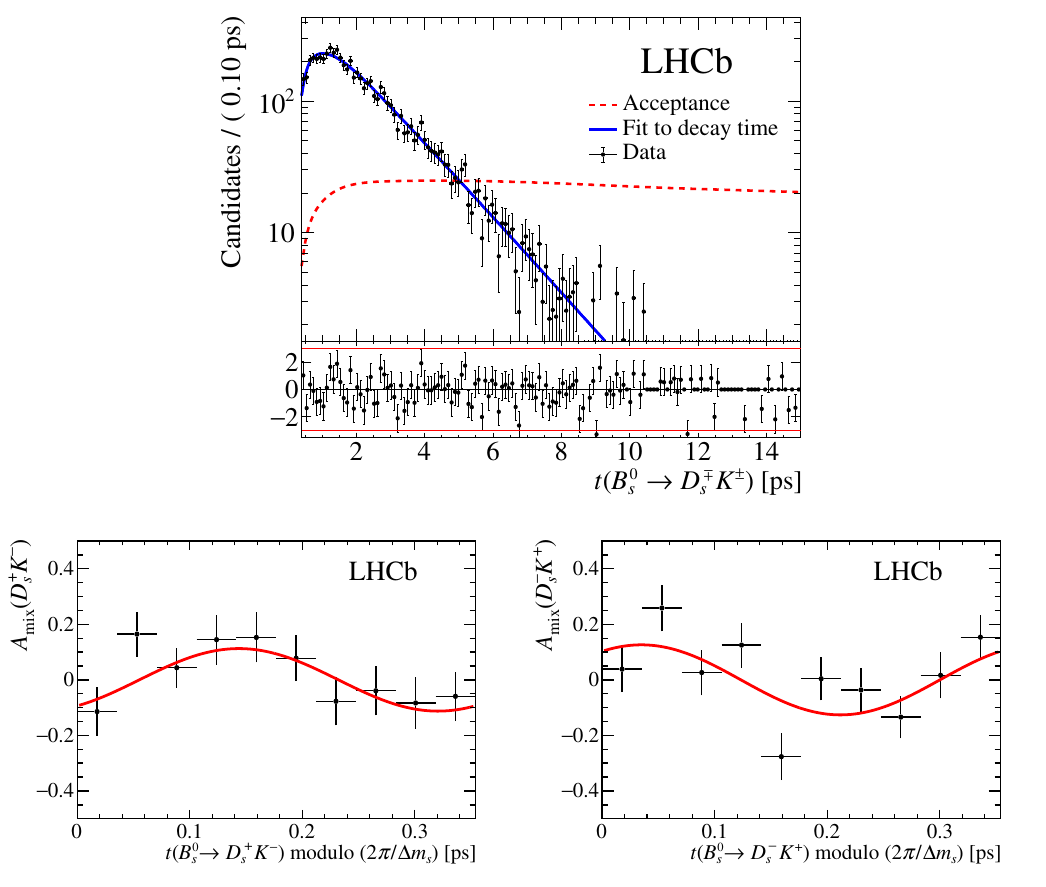
Figure 6 . The (top) decay-time distribution of B 0 D (cid:7) K (cid:6) candidates obtained by the sPlot s ! s technique. The solid blue curve is the result of the sFit procedure and the dashed red curve shows the decay-time acceptance in arbitrary units, obtained from the sFit procedure applied to the B 0 D (cid:0) (cid:25) + candidates and corrected for the ratio of decay-time acceptances of B 0 D (cid:7) K (cid:6) and s ! s s ! s B 0 D (cid:0) (cid:25) + from simulation. Normalised residuals are shown underneath. The CP -asymmetry s ! s plots for (bottom left) the D + K (cid:0) (cid:12)nal state and (bottom right) the D (cid:0) K + (cid:12)nal state, folded into s s one mixing period 2 (cid:25)= (cid:1) m s , are also